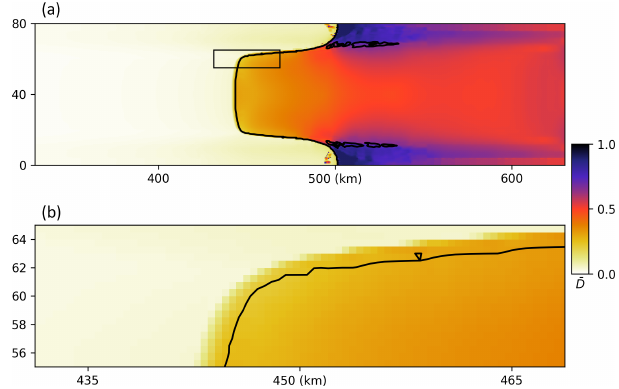
Figure 3. Vertically averaged damage field D in experiment IceD0. A steady state with its grounding line (solid black contour) crossing the centre of the channel around x = 450km was found by decreas- ing the spatially uniform rate factor to A (cid:48) = 1 . 5 × 10 − 18 Pa − 3 a − 1 . The resulting state is then close to the steady state without the dam- age model (i.e. with D = 0) and A = 2 . 0 × 10 − 17 Pa − 3 a − 1 . The damage field grows from D ≈ 0 to D ∼ 1 / 3 around the grounding line to D ∼ 1 / 2 in the lateral centre of the shelf and D ∼ 1 close to the domain boundaries. Panels (b) plots a magnified portion of panel (a) and shows damage increasing in the few kilometres up- stream from the grounding